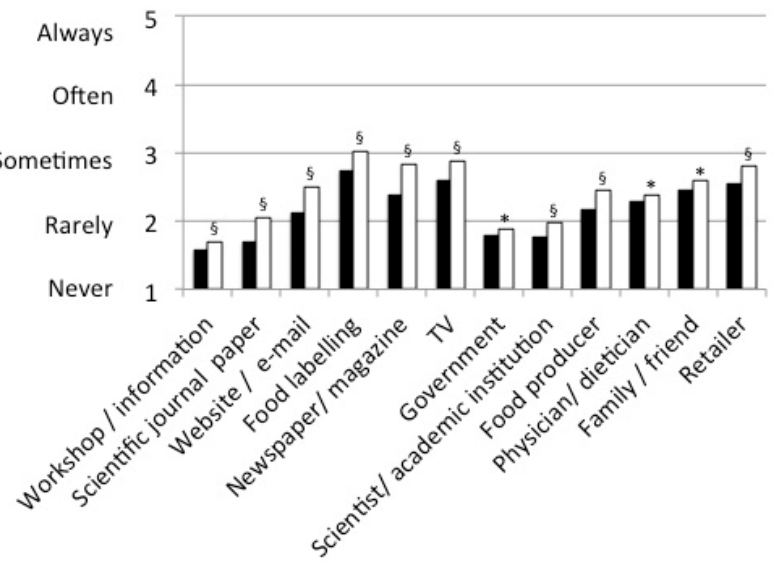
Figure 3. Frequency of used media sources and used information sources for obtaining information about new food products for the two protein knowledge groups separately ( n = 1825). * Significant difference between the two knowledge groups based on the Mann–Whitney U test at the <0.05 level, § at the <0.001 level.